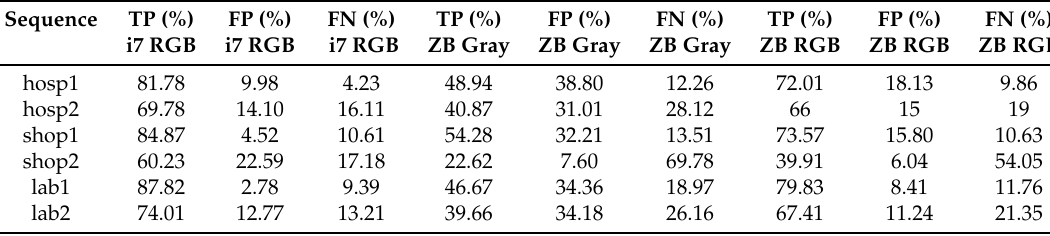
Table 8. Tracking algorithm results comparison (represented in